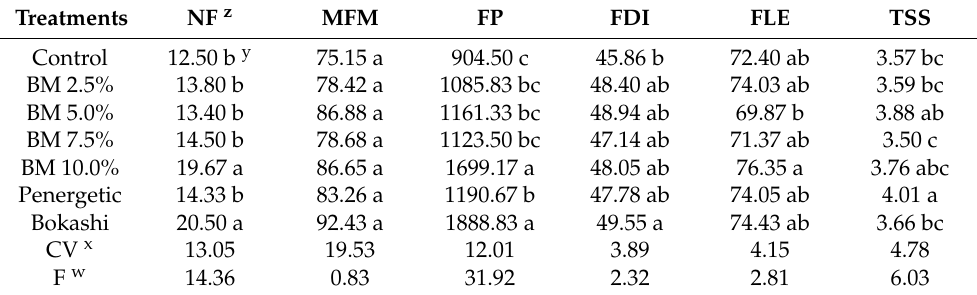
Table 2. Fruit production variables of tomato (cv. HS 1188 Vero) fertilized with boiled manure (BM), Penergetic, or Bokashi. Second cycle. Londrina, Brazil, 2016.